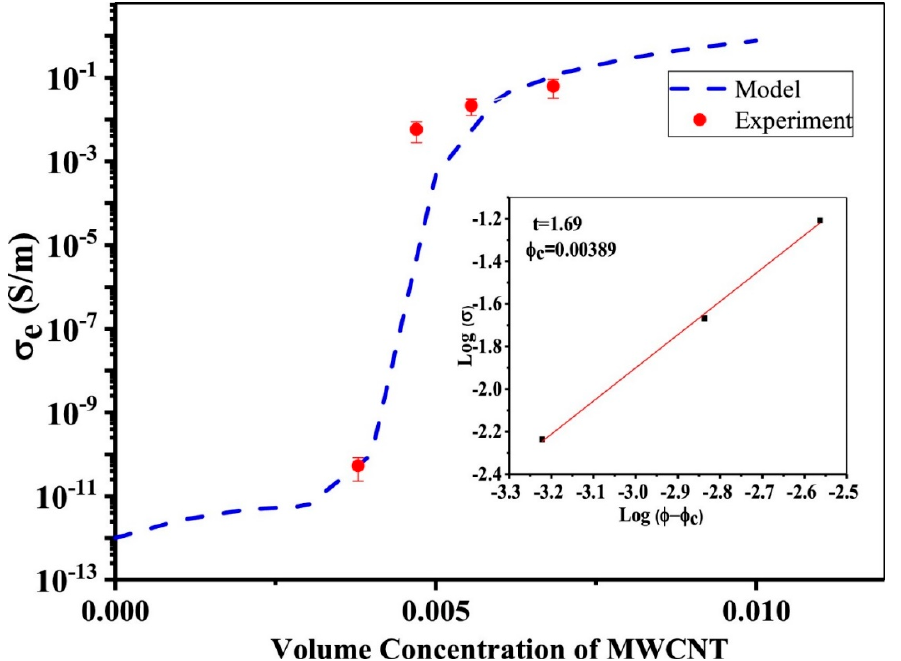
Figure 7. The plot of predicted effective electrical conductivity compared with experimental data for BC/MWCNT nanocomposite aerogels (the inset illustrates the log conductivity against log ( ϕ - ϕ c)) (Reproduced with permission [142]).